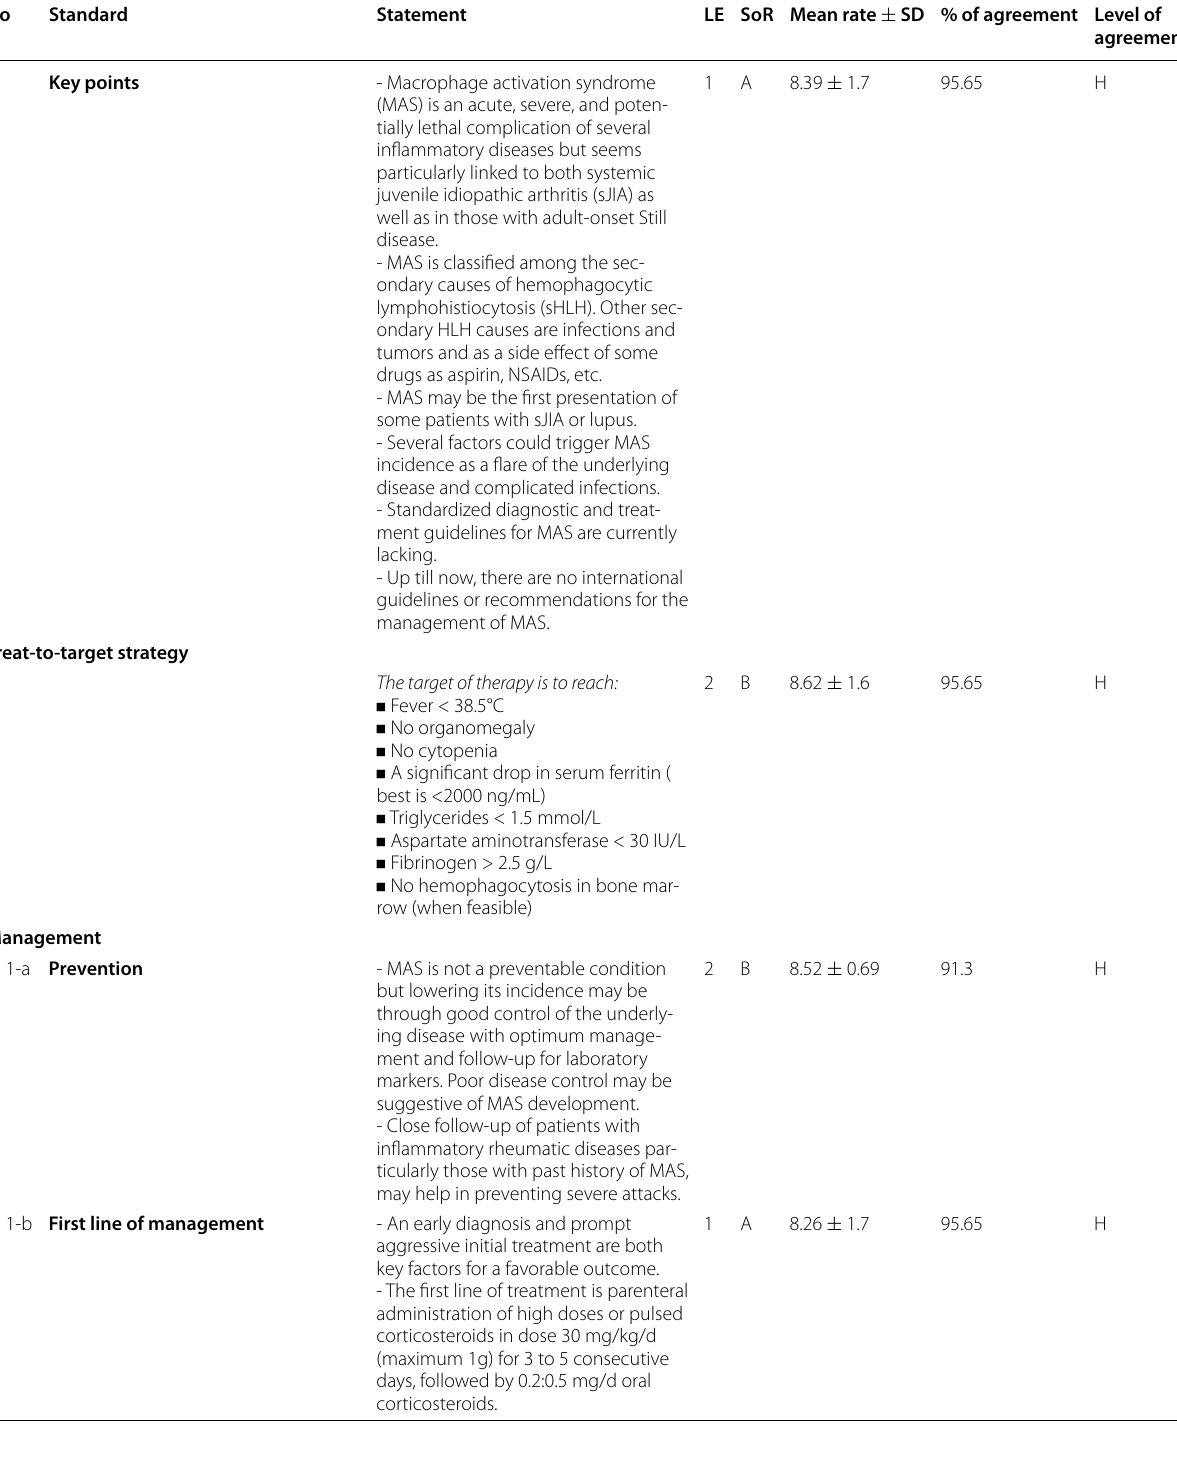
Table 6 Summary of recommendations